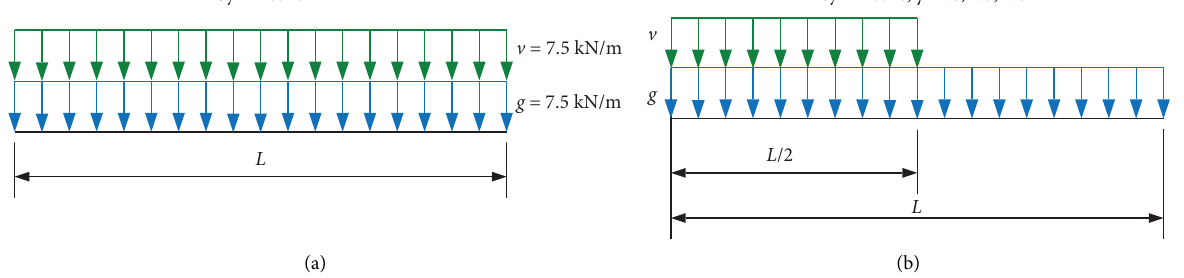
Figure 3: Loading cases and intensities of variable and permanent loadings. (a) Symmetric loadings, (b) Asymmetric loadings: at c � 1.0 v � g � 10.0 kN/m; at c � 1.50 v � 12.86 kN/m, g � 8.57 kN/m; at c � 2.0 v � 15 kN/m, g � 7.5